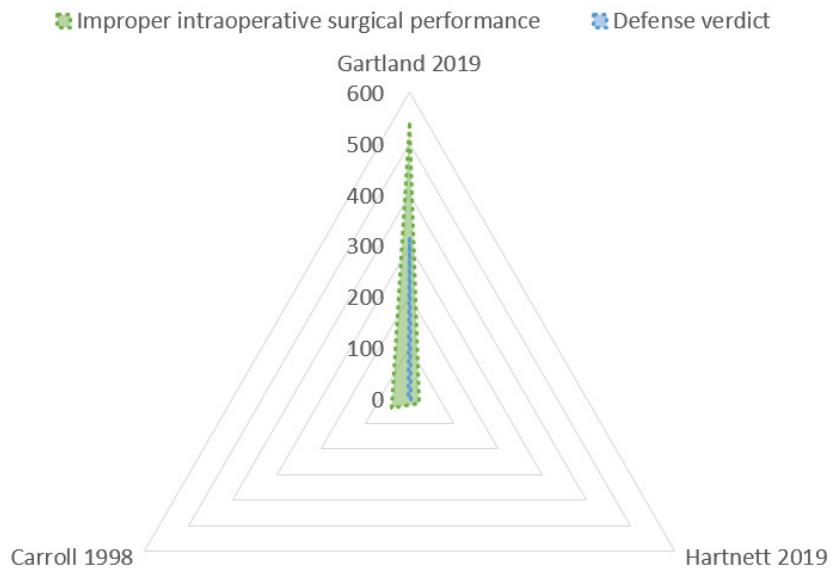
Figure 9. Radar chart: Defensive verdicts in litigations for problematic visualization. The largest polygon (green area: improper intraoperative surgical performances consequent to poor decision making or misinterpretation—“problematic visualization”) is the most common cause of a lower rate of defensive verdicts in litigations (blue area).